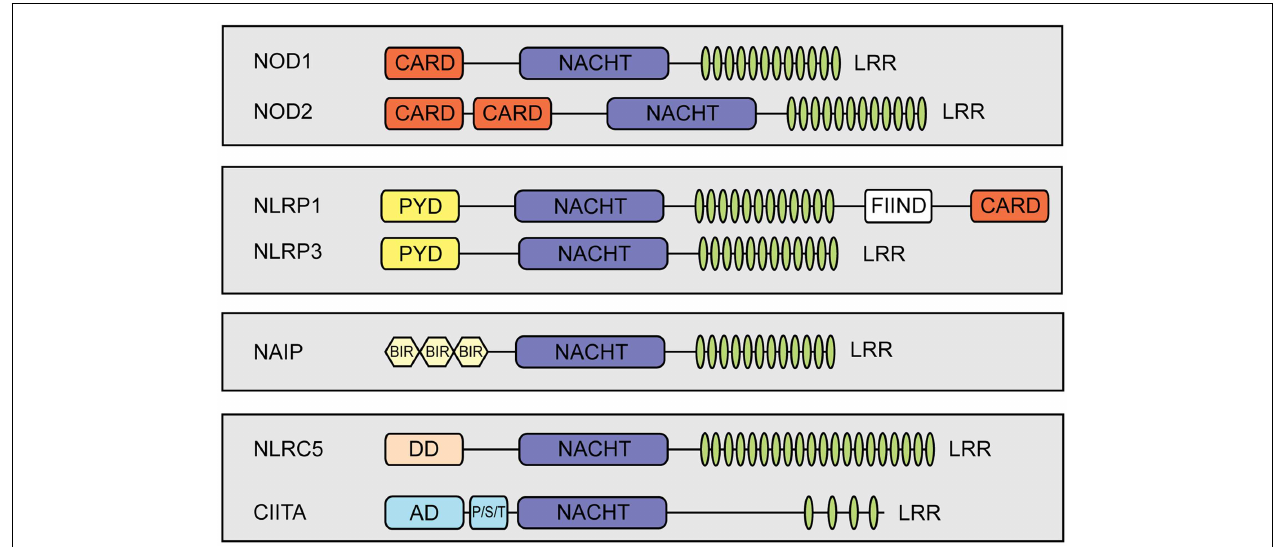
(LRRs) and a variable N-terminal effector domain.The effector domain can be a pyrin domain (PYD), a caspase recruiting domain (CARD), or a baculovirus inhibitor of apoptosis repeat (BIR). Additional abbreviations: FIIND, function to find; DD, death-domain different from a typical CARD and PYD; AD, activation domain; P/S/T, proline/serine/threonine-rich protein